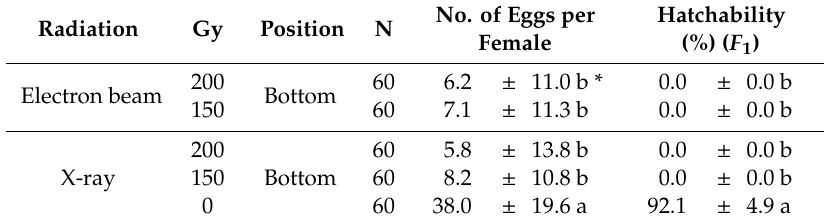
Table 8. Mean ( ± SD) adult fecundity (no. of eggs per female) hatchability (%) of the eggs (F1 generation) of T. vaporariorum irradiated by 150, 200 Gy of electron beam and X-rays at bottom location in boxes filled with strawberry